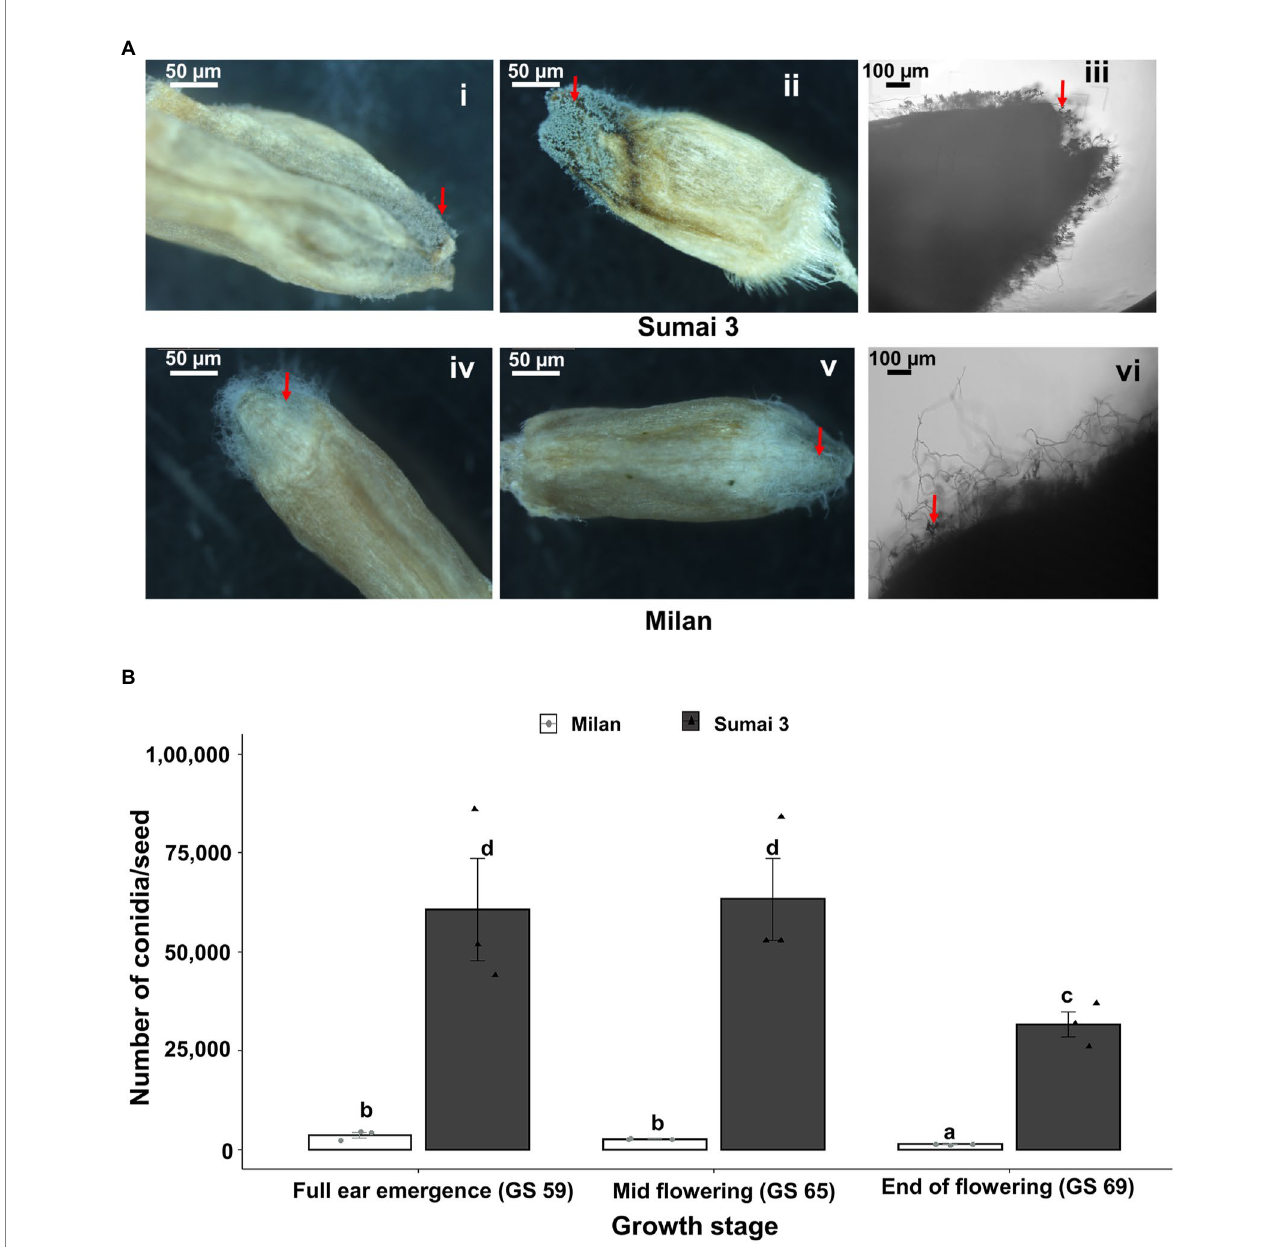
FIGURE 4 Sporulation rate of MoT in seeds from wheat plants spray inoculated with a MoT conidial suspension of 1 × 10 5 conidia/ml on ears at three different flowering stages. (A) MoT conidia on representative seeds of Sumai 3 and Milan. The red arrow indicates the sporulation of MoT conidia on the seeds. Ai , Aii , Aiv , Av (scale bar 50 μ m) were photographed under a stereomicroscope, Aiii and Avi were photographed under a compound light microscope (scale bar 100 μ m). (B) Number of MoT conidia per seed in Sumai 3 and Milan seeds collected from different inoculation time points. For each cultivar, bars represent the mean (± standard error) of total number of conidia per seed of each ear inoculation time point. ANOVA with Tukey test was performed, and treatments with the same letters at the cultivar level were not significantly different ( n = 3; one replicate contained 20 seeds of each cultivar at each inoculation time point; p = 0.05). Each data point represents one replicate consisting of 20 randomly selected